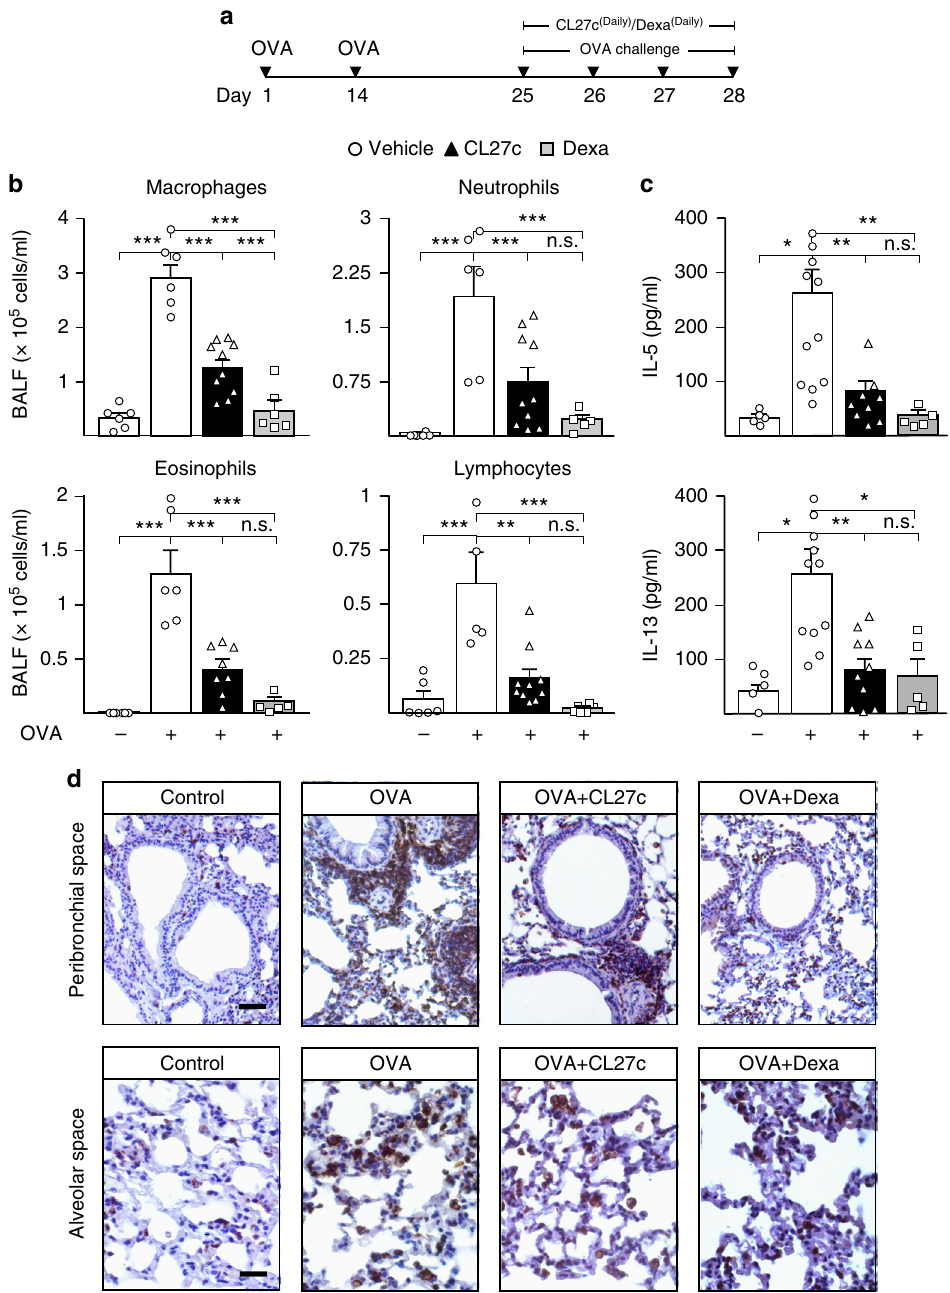
Fig. 2 CL27c reduces in fl ammation in a model of OVA-induced acute allergic asthma. a Protocol of OVA-induced acute allergic asthma and treatment regimen with inhaled CL27c (2 mg/ml) or Dexamethasone (Dexa, 3 mg/kg, i.p.). b Quanti fi cation of macrophage, neutrophil, eosinophil, and lymphocyte in fi ltration in BALF of control and OVA-treated mice in the presence of vehicle (white bars), CL27c (black bars) or Dexa (gray bars) (from left to right, macrofages n = 6, 6, 10, 6, neutrophils n = 6, 6, 10, 5, eosinophils n = 6, 6, 8, 5, and lymphocytes n = 6, 5, 10, 6 independent experiments, respectively). c Analysis of IL-5 and IL-13 levels in the lung tissue of control and OVA-treated mice in the presence of vehicle, CL27c or Dexa (from left to right IL-5 n = 5, 11, 9, 5 and IL-13 n = 5, 11, 10, 5 independent experiments, respectively). d Histopathological analysis of lung of peribronchial (upper panels) and alveolar (lower panels) spaces showing CD18 + leukocyte in fi ltration (brown cells) in CL27c or Dexamethasone (Dexa)-treated mice after the OVA challenge. Bar = 50 μ m (upper panel) and 10 μ M (lower panel). Results represent mean ± s.e.m., * P < 0.05, ** P < 0.01, *** P < 0.001 determined using one-way ANOVA followed by Bonferroni post-hoc test. n . s . = non-signi fi cant ( P >